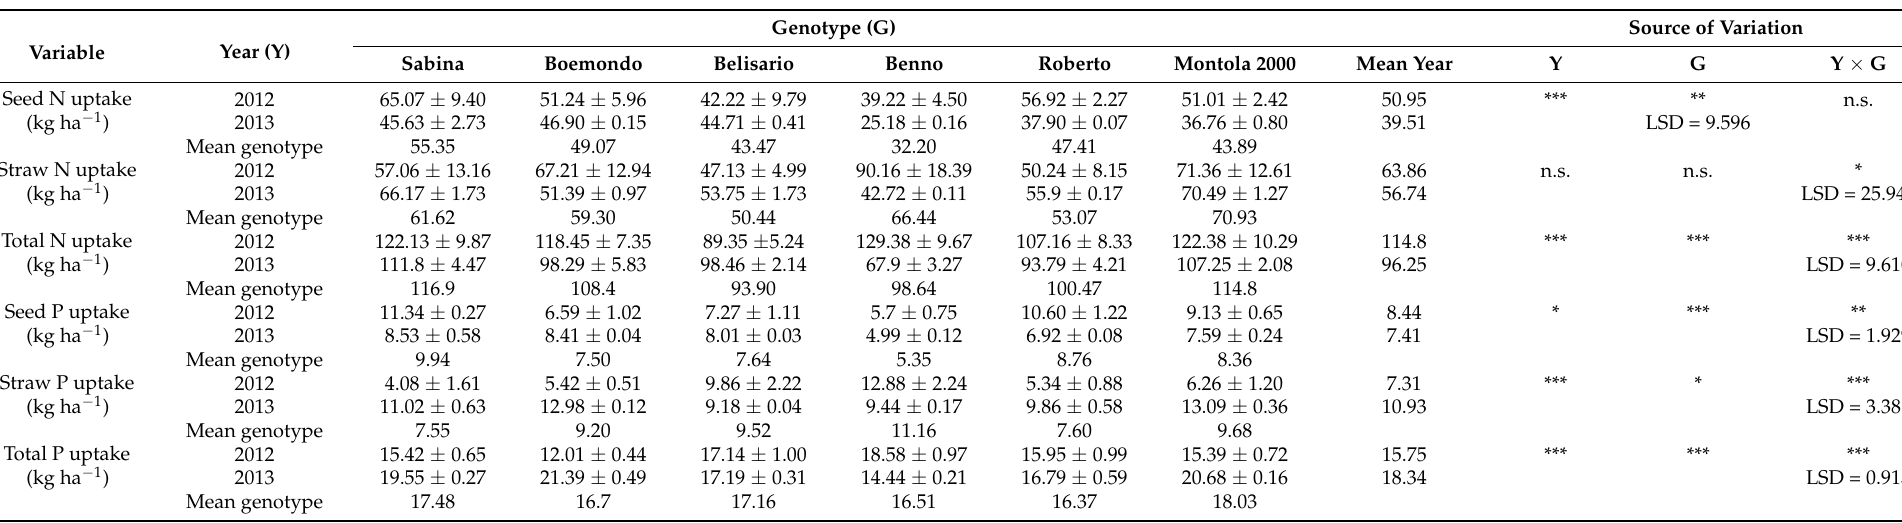
Table 6. Nitrogen and phosphorus uptake (means ± SE) in seeds and straw of six safflower genotypes sown in spring during two consecutive growing